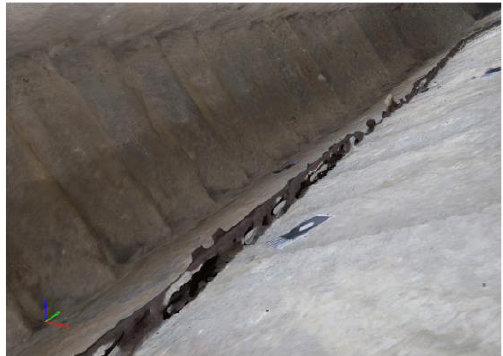
Figure 13: Result of the 3D reconstruction for the section of the